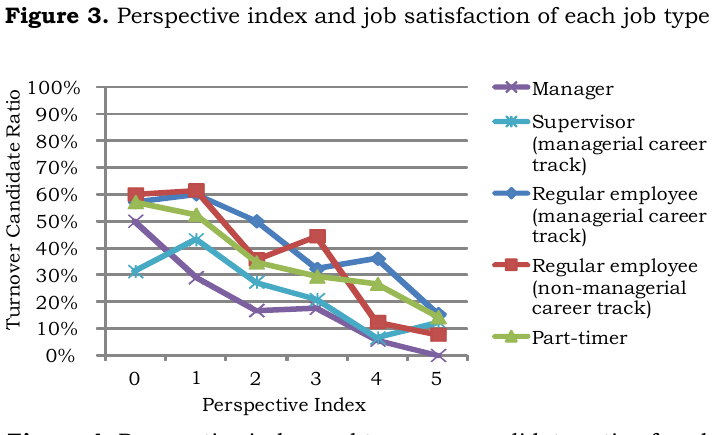
Figure 4. Perspective index and turnover candidate ratio of each job